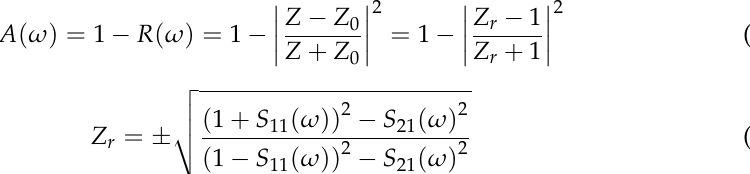
spectra with different conductivities.